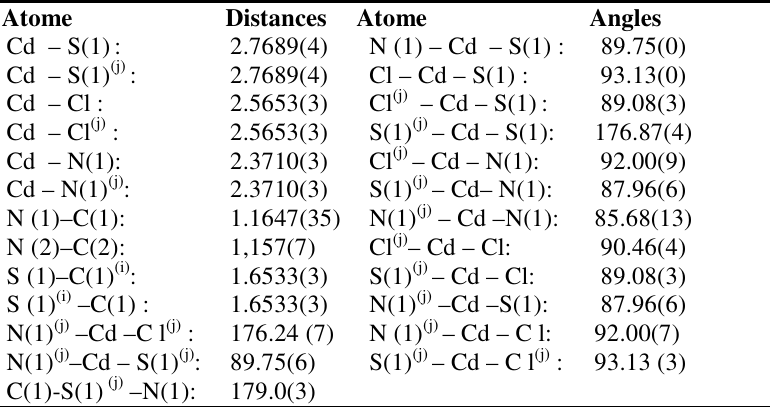
Fig.1. ORTEP stereoscopic projection of the crystal packing. Table 2. Principal intermolecular distances (Å) and bond angles